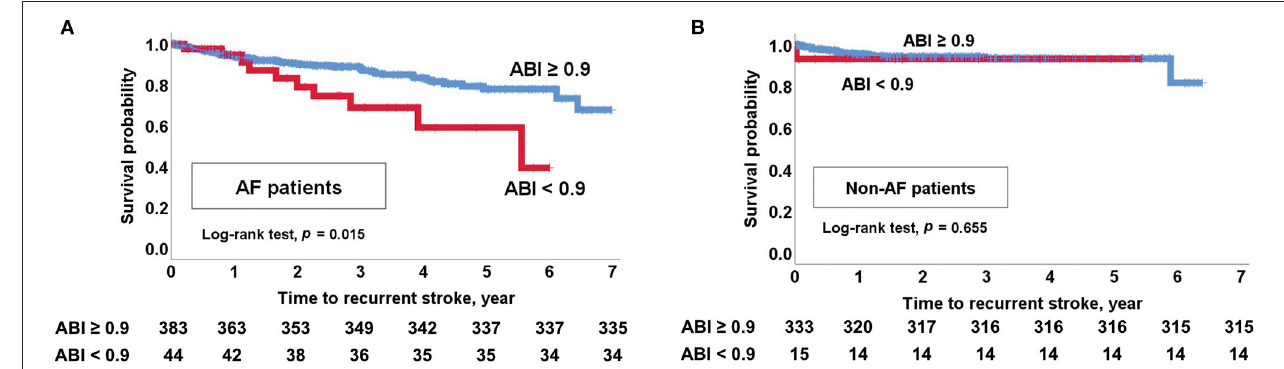
FIGURE 3 | Kaplan-Meier survival analysis. (A) Recurrent stroke in AF patients with an ABI < 0.9. (B) Recurrent stroke in non-AF patients with an ABI < 0.9. ABI, ankle-brachial index; AF, atrial